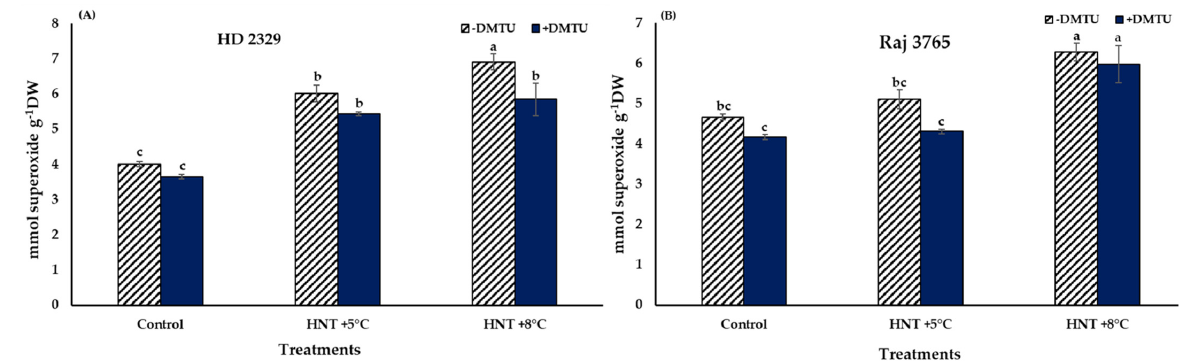
Figure 2. Effect of HNT on superoxide radical content in pistil of wheat genotypes ( A ) HD 2329 (sensitive) and ( B ) Raj 3765 (tolerant) under control, HNT (+5 °C) and HNT (+8 °C) conditions in absence and presence of ROS scavenger (DMTU). Bars represent mean ± SE. Bars with common letter are not significantly different between temperature treatments in a genotype at p < 0.05.